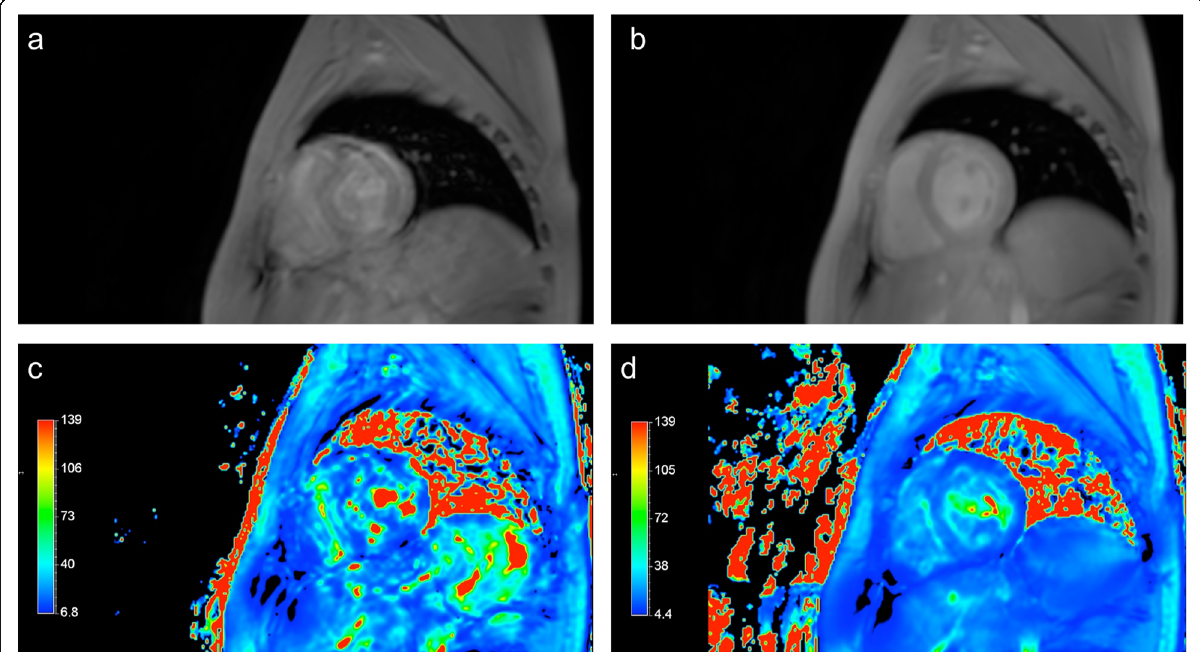
Fig. 3 Example of data excluded from analysis regarding a 5-year old boy with Diamond – Blackfan anaemia who underwent the cardiac magnetic resonance without anaesthetic support. a Original image obtained using the breath-holding technique. b Original image obtained using the free- breathing technique. c T2* map obtained using the breath-holding technique. d T2* map obtained using the free-breathing